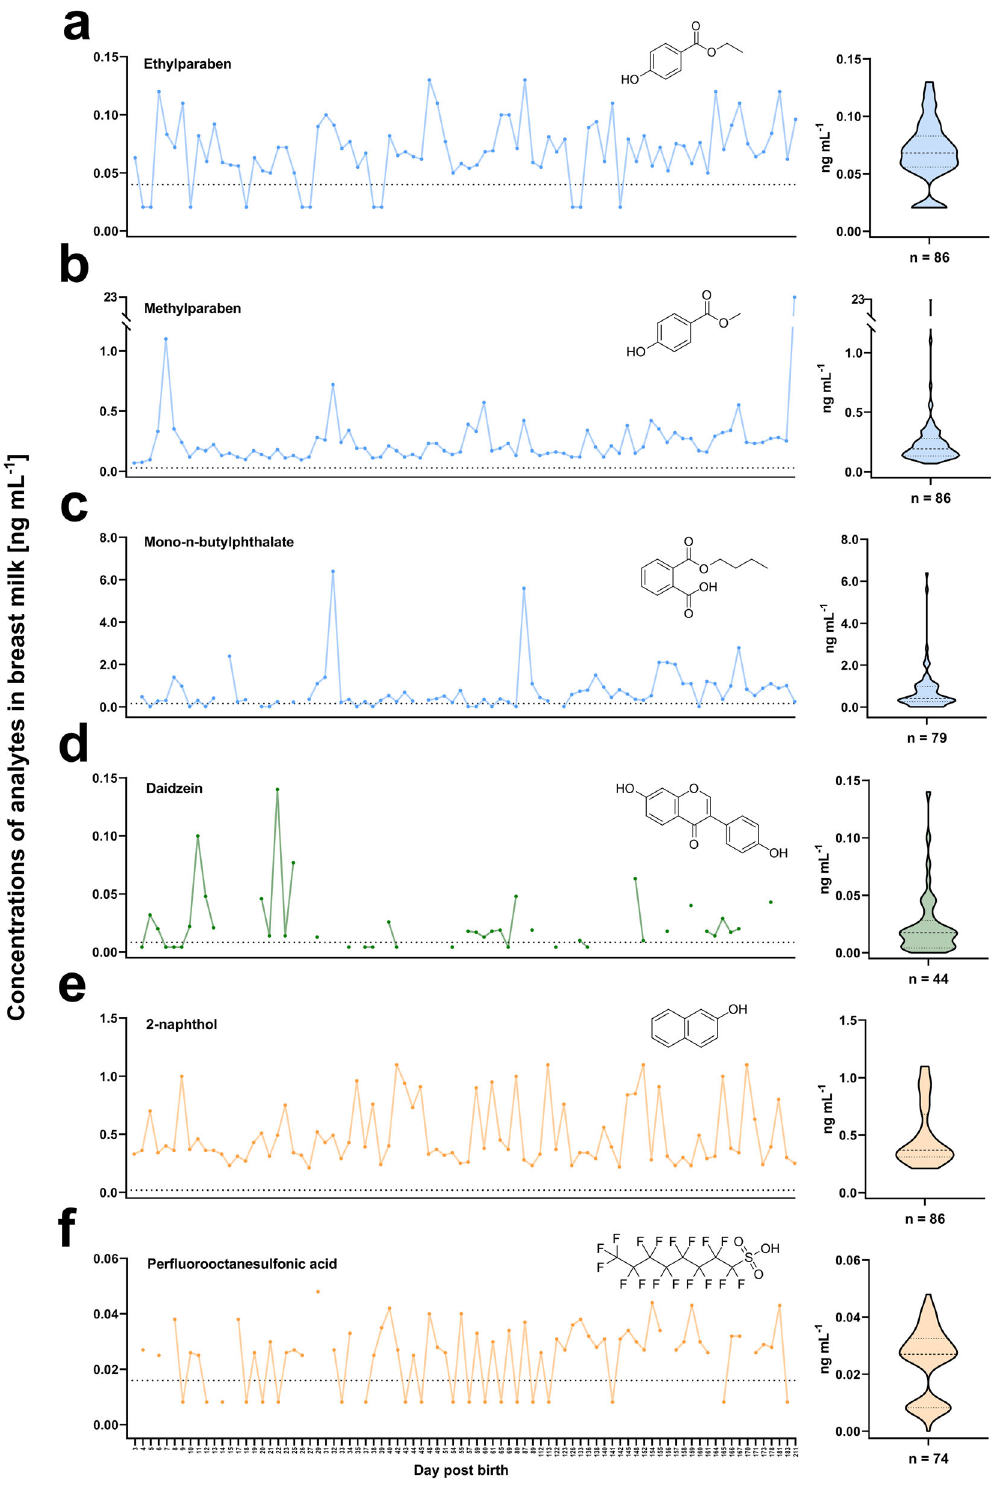
Fig. 4 Exposure dynamics of selected xenobiotics identi fi ed in breast milk. a – f Detected levels of ethylparaben, methylparaben, mono-n-butyl phthalate (plastic- and consumer product-associated, depicted in blue), daidzein (food-associated, depicted in green), 2-naphthol and per fl uorooctanesulfonic acid (industrial- and/or environment-associated, depicted in orange), respectively. Samples were taken between day 3 and 211 post-partum ( n = 86). The horizontal dotted line indicates the limit of quantitation (LOQ) for the respective compound. Samples were acquired over an irregular schedule (marked on the x -axis) as the infant was fed before sampling and, in some cases, no breast milk remained for laboratory analysis. Dots connected by lines indicate detection on consecutive days of sampling. Analytes that were determined below the respective LOQ values were set to half the LOQ for calculations and plotting. Violin plots depict the distribution of concentrations over the observed period. Horizontal bars inside the plot display the fi rst quartile, the median and the third quartile. The number of positive samples is reported on the x -axis for each respective